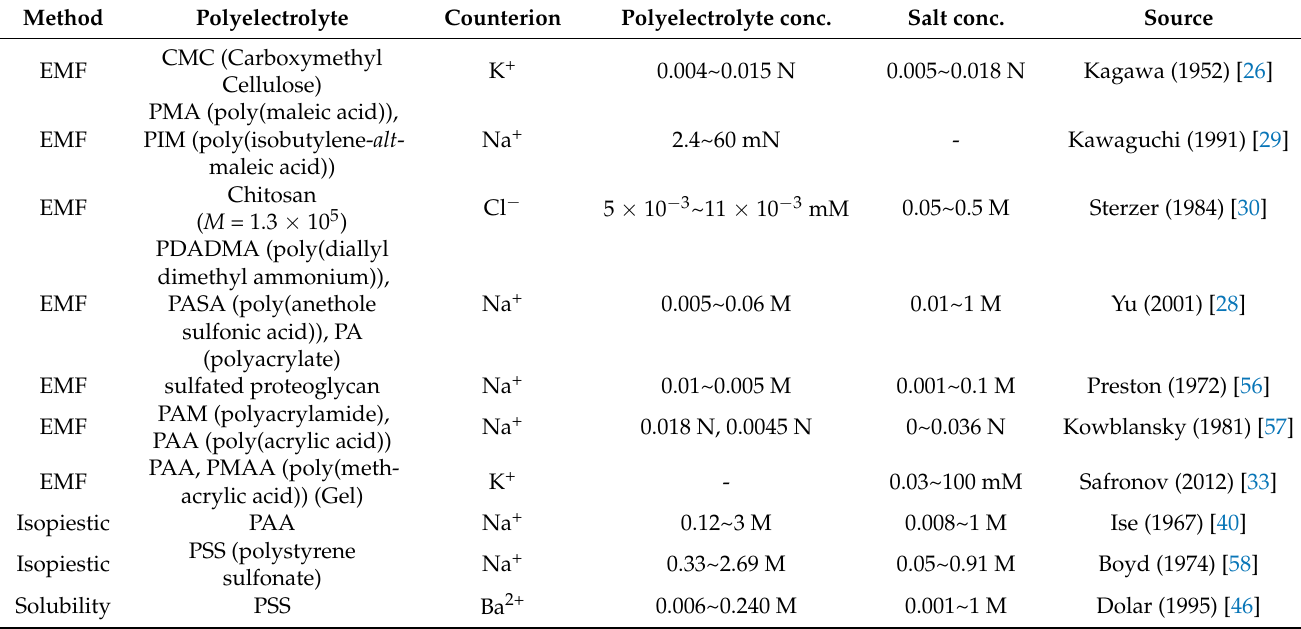
Table 1. A summary for experimental methods of activity coefficient in polyelectrolyte